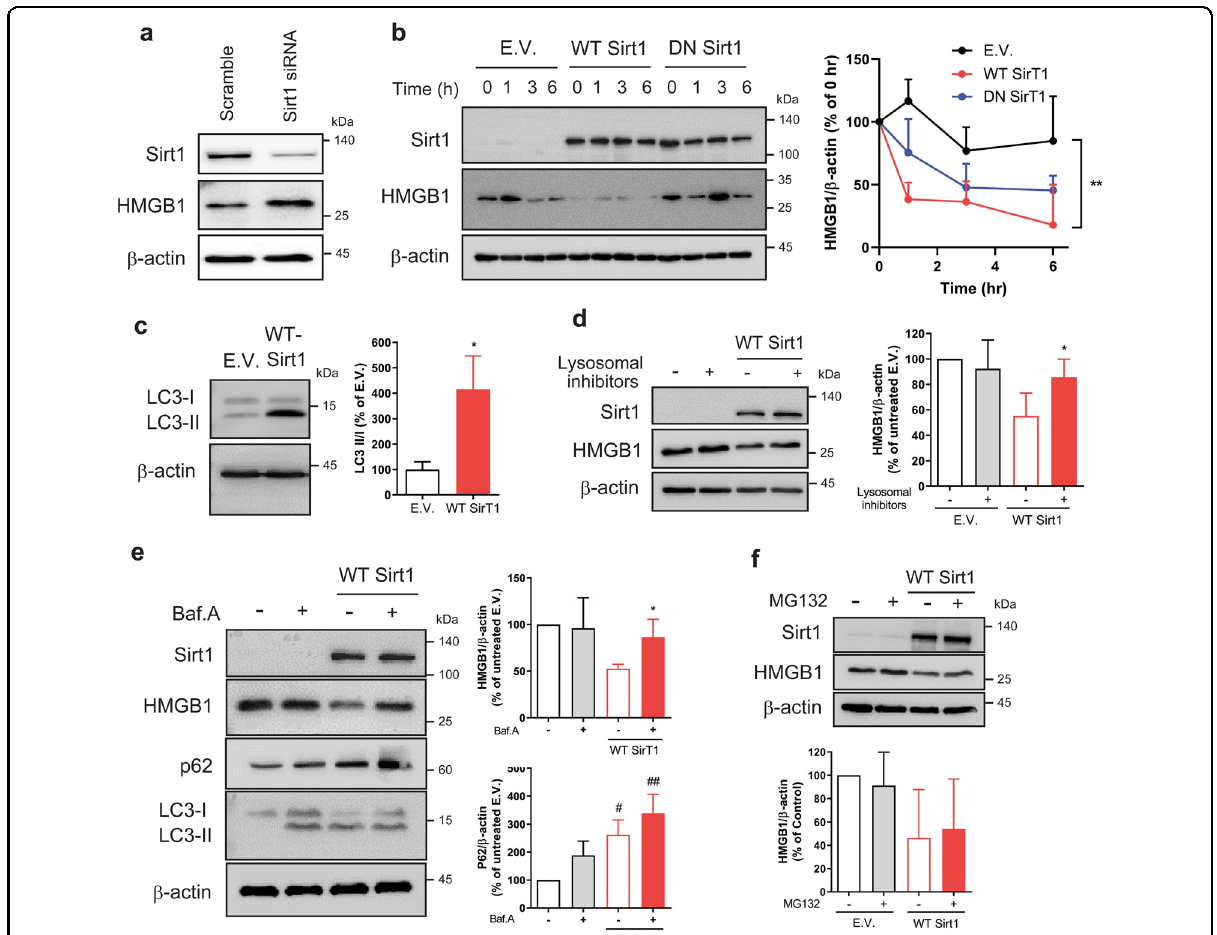
Fig. 4 Sirt1 reduced the protein stability of intracellular HMGB1 via an autophagolysosomal pathway. a HBMVECs were transfected with scrambled siRNA or Sirt1 siRNA for 24 h, and the levels of Sirt1 and HMGB1 in cell lysates were analysed by western blotting; β -actin was used as a loading control. b HBMVECs were transfected with empty vector (E.V.), wild-type SIRT1 (WT Sirt1) or dominant negative mutant SIRT1 (DN Sirt1) plasmids, as described in the methodology. The levels of Sirt1 and HMGB1 were analysed by western blotting in the genetically modi fi ed